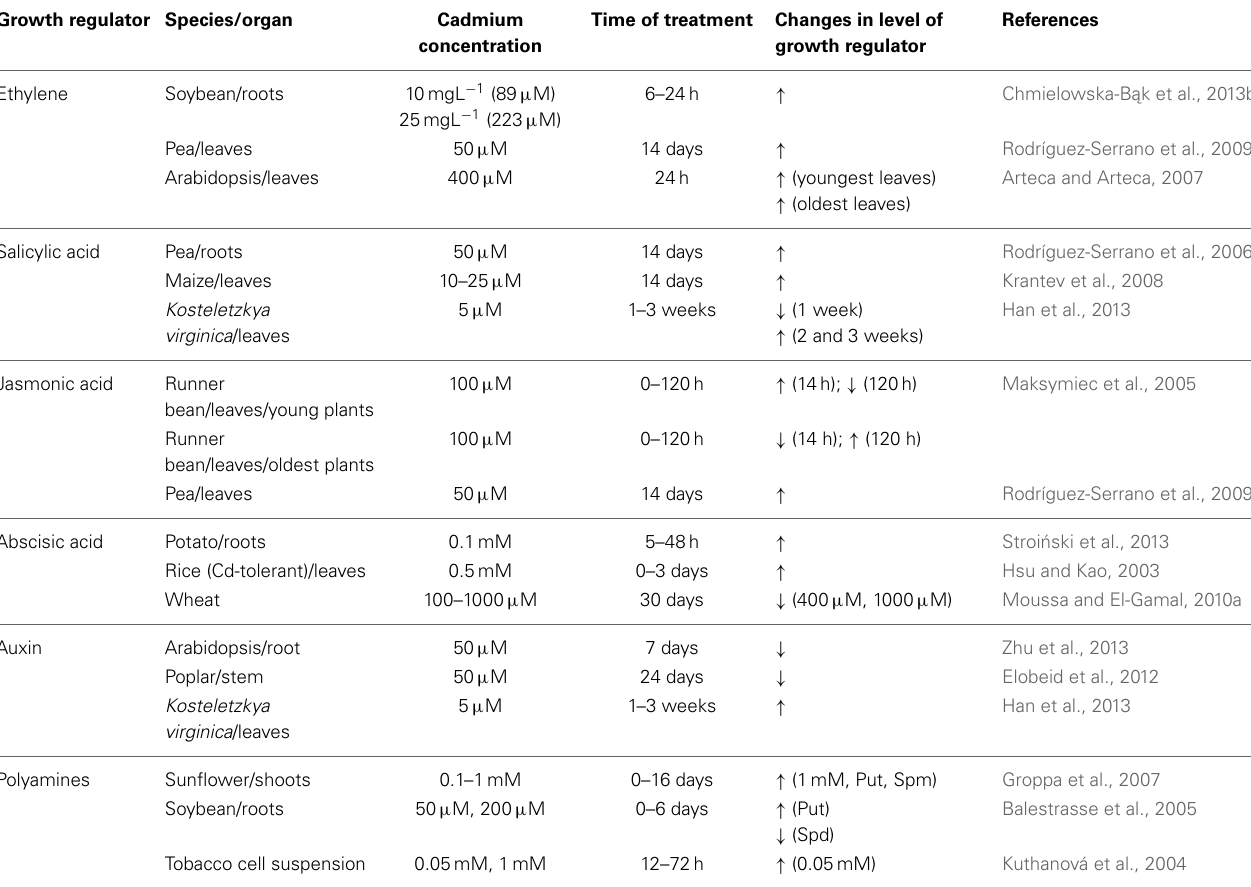
Table 3 | Exemplary studies of growth regulators level (endogenous) under different experimental